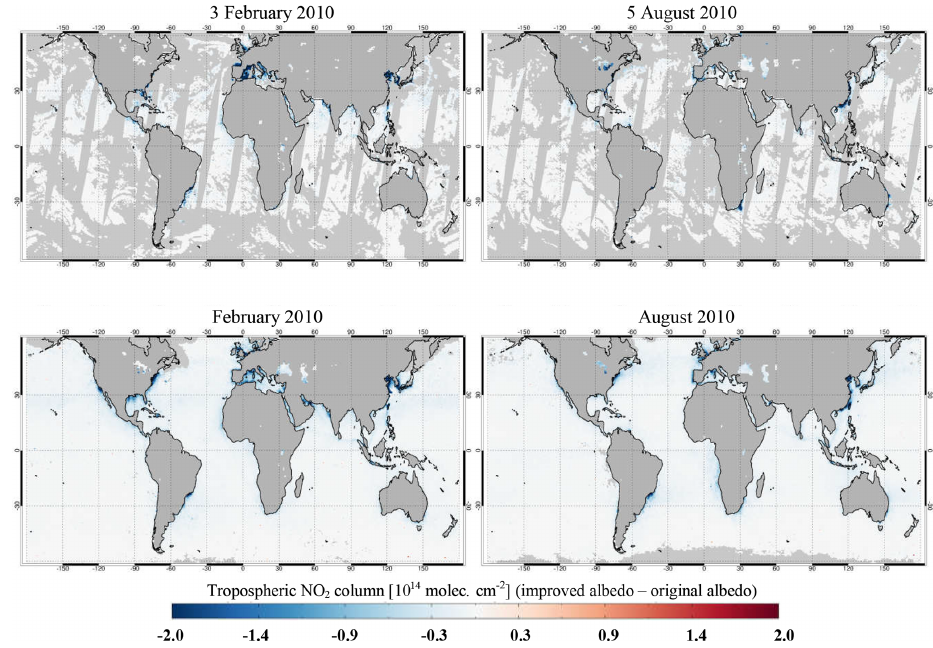
Figure 5. Differences in the GOME-2 tropospheric NO 2 columns retrieved using the original GOME-2 LER climatology and the GOME-2 LER data improved by the ocean surface albedo parameterisation for a given day and for the monthly average in February and August 2010. Only measurements with a cloud radiance fraction less than 0.5 are included.